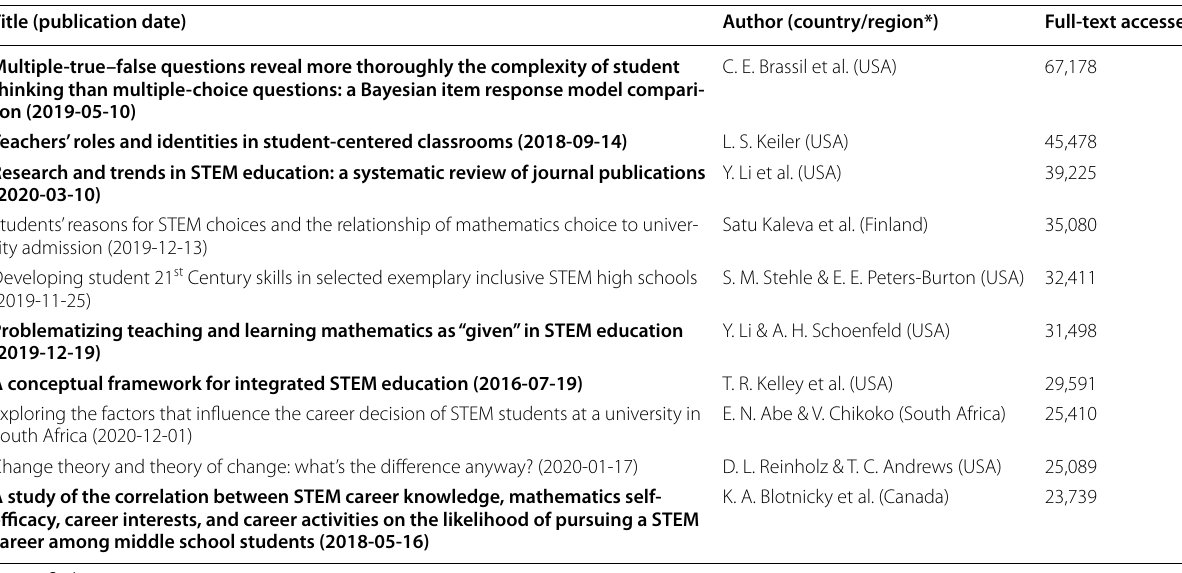
Table 2 Top 10 full-text article accesses in